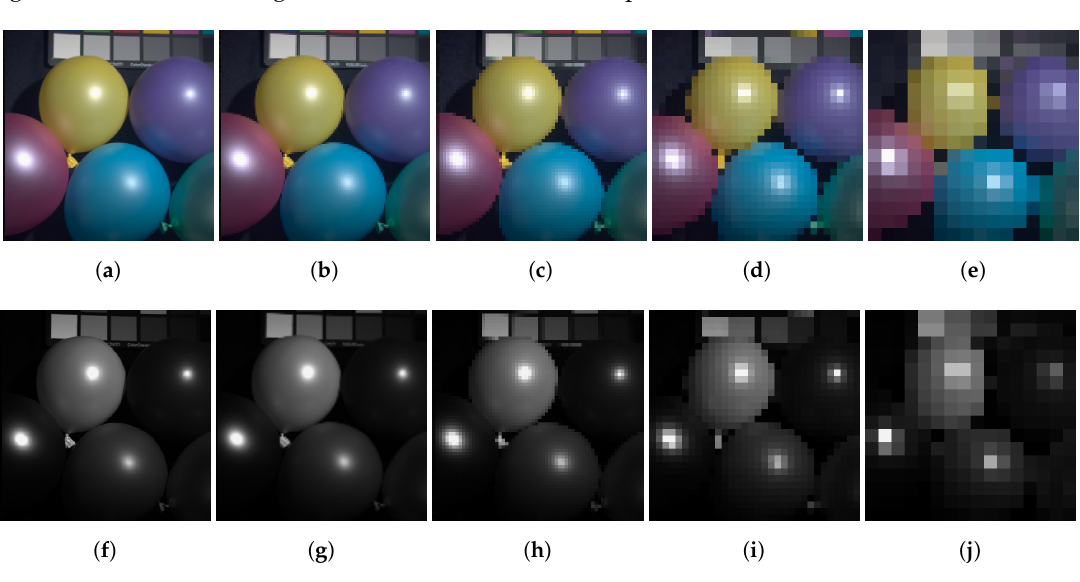
Figure 4. Balloon’s set example of the resized inputs used during training for each image in the CAVE dataset, for the ratios of 2 ( a , f ), 4 ( b , g ), 8 ( c , h ), 16 ( d , i ), and 32 ( e , j ), with resolutions of 256 × 256, 128 × 128, 64 × 64, 32 × 32, and 16 × 16